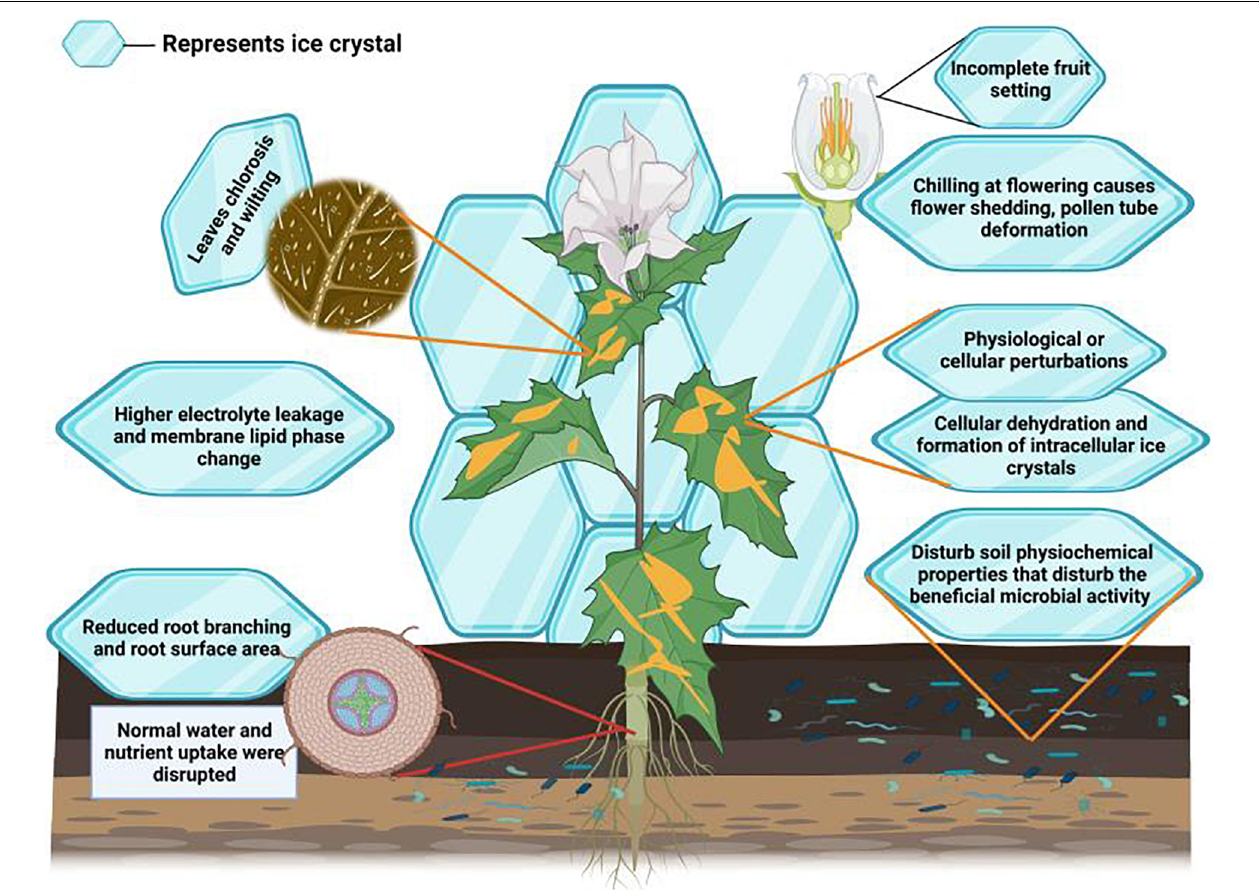
FIGURE 2 | Effect of cold stress on plants. Cold stress induces the formation of crystal which reduces membrane integrity, causes electrolyte leakage and lipid saturation, reduces root growth which in turn decreases the water and nutrient uptake. Moreover, cold stress also causes leaf wilting and chlorosis and disturbs photosynthetic performance and microbial activities, and induces flowering shedding, deformation of pollen tube, incomplete fruit setting and results in significant growth and yield losses.